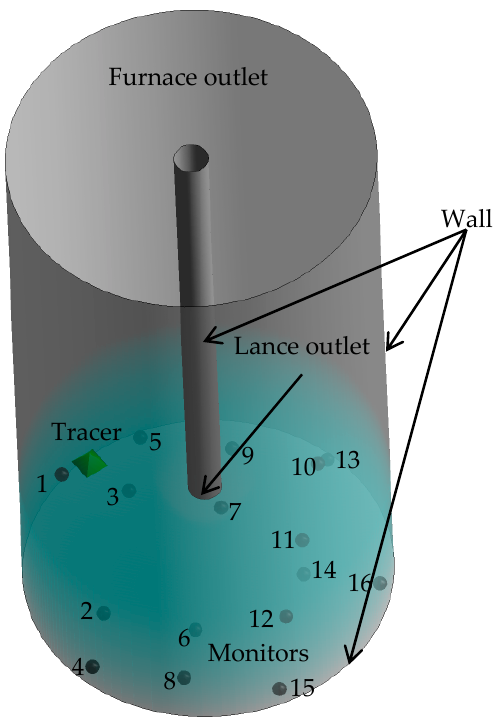
Figure 2. Boundary conditions and location of monitors.